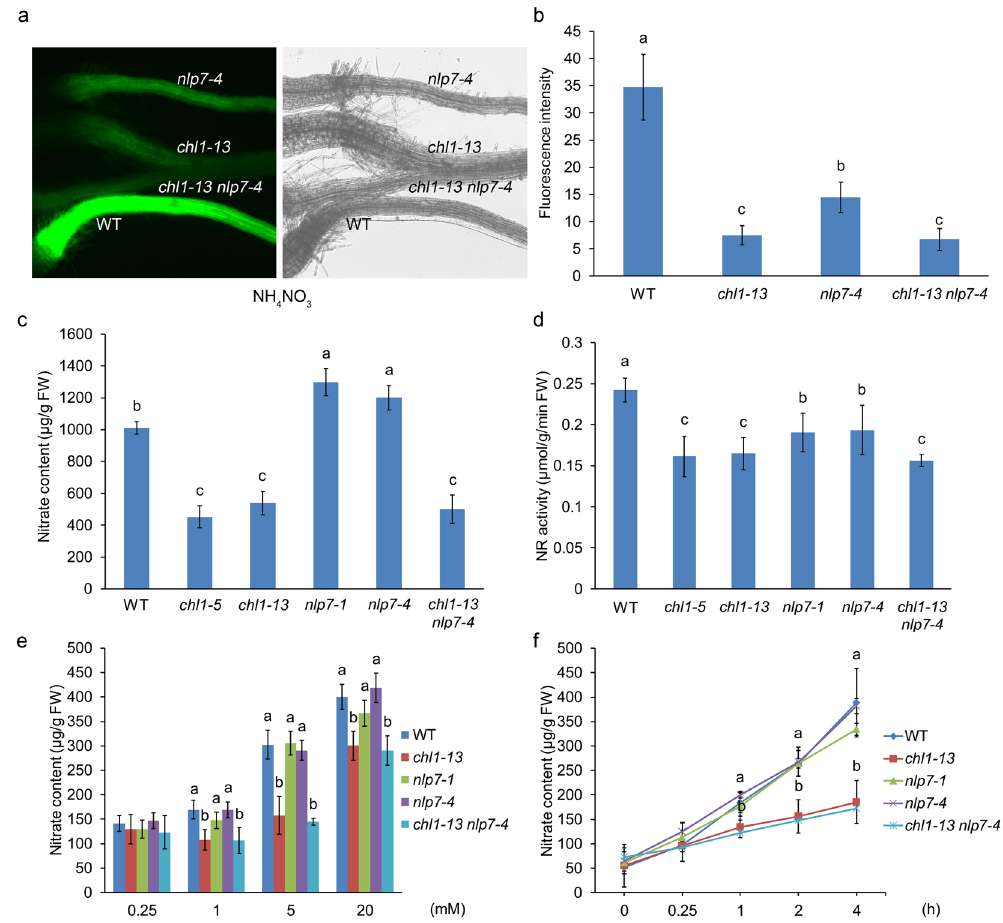
Figure 2. NLP7 functions in the same nitrate regulation pathway as NRT1 . 1 . ( a ) Root YFP observation of WT, chl1-13 , nlp7-4 , and chl1-13 nlp7-4 plants. Fluorescence and light images of seedlings which grown on the medium with 10 mM ammonium nitrate for 5d were captured using a fluorescence microscope. ( b ) Quantification of root YFP signal levels of WT, chl1-13 , nlp7-4 , and chl1-13 nlp7-4 plants. The same conditions for plants growth were used as ( a ). Error bars mean ± SD of sixty biological replicates. The significant difference ( p < 0.05, t test) is indicated by different letters. ( c ) Nitrate content in WT, chl1 , nlp7 , and chl1-13 nlp7-4 plants. Seedlings grown on the medium with 10 mM ammonium nitrate for 7d were sampled for nitrate content detection. Error bars mean ± SD of four biological replicates. The significant difference ( p < 0.05, t test) is indicated by different letters. FW, fresh weight. ( d ) Nitrate reductase activity in WT, chl1 , nlp7 , and chl1-13 nlp7-4 plants. The same growth conditions were used as ( c ). Error bars mean ± SD of four biological replicates. The significant difference ( p < 0.05, t test) is indicated by different letters. FW, fresh weight. ( e ) and ( f ) Nitrate accumulation in WT, nlp7 , chl1-13 and chl1-13 nlp7-4 plants. Seedlings were planted on the medium with 2.5 mM ammonium succinate for 7 d followed by the treatments with different KNO 3 concentrations for 2 h ( e ) or with 5 mM KNO 3 for different times ( f ). The whole plants were used for nitrate content test. Error bars mean ± SD of four biological replicates. The significant difference ( p < 0.05, t test) is indicated by different